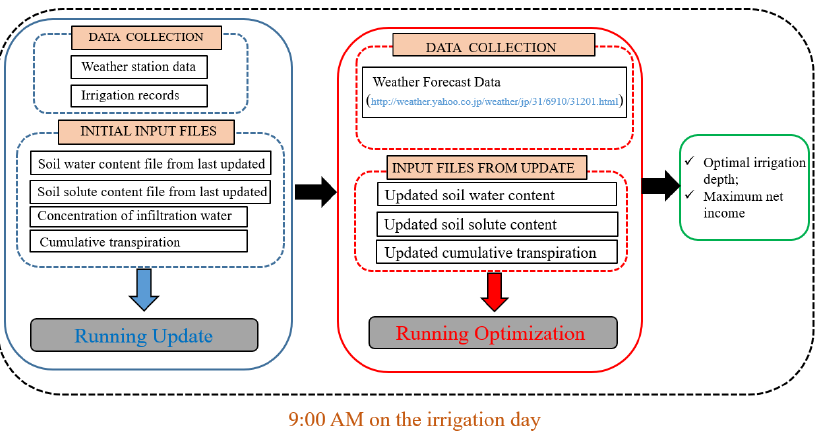
Figure 1. Steps of the proposed irrigation depth determination schedule. Two main steps (Running Update and Optimization runs) were performed by WASH_2D at 9:00 AM of the irrigation day. Left blue box shows the first step of simulation (Update). The right red box shows the second step of simulation (Optimization). The black arrow between two boxes shows the directions of data flow.